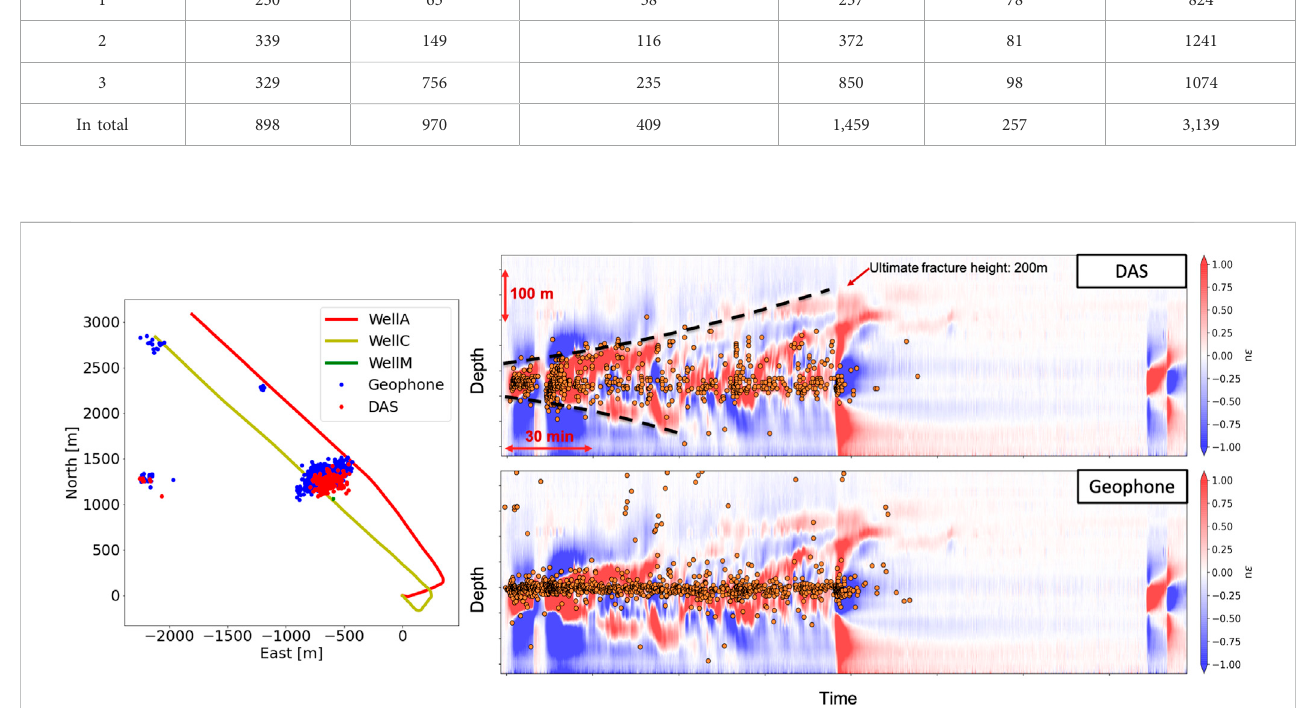
FIGURE 11 Case study 2: Left: map view of events from a single hydraulic fracturing stage. Right: Time-depth distribution of fi ber strain rate in vertical well M, and microseismic events (orange dots) from DAS (upper) and geophone